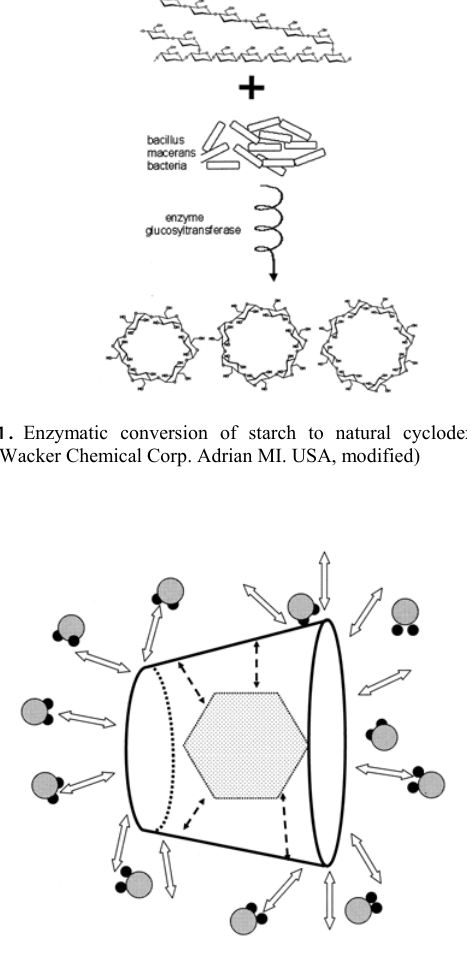
FIGURE 2. Lipophilic molecule encapsulated by a cyclodextrin. Note; arrows represent non- covalent thermodynamic